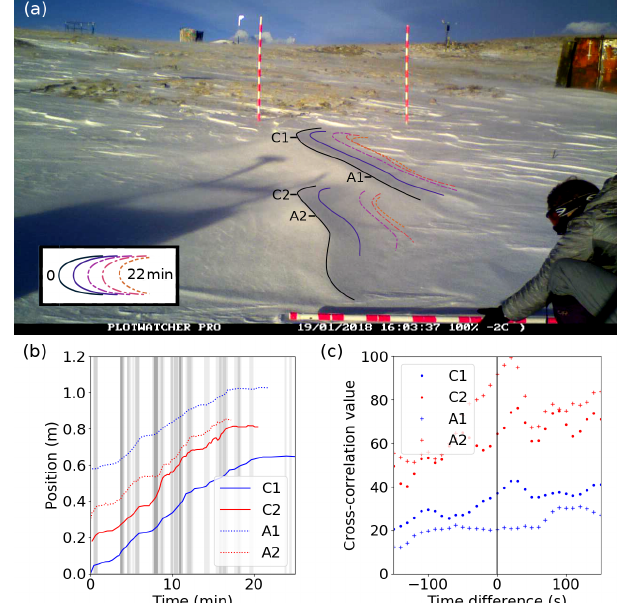
Figure 4. Movement of two barchan dunes on Niwot Ridge, Col- orado, from 16:03 to 16:28 on 19 January 2018, and analysis of the effect of pulses of blowing snow on dune movement. See video S1 at 1:07. (a) Dunes at 16:03. Colored lines show the crest posi- tion through time, taken from time-lapse imagery. Poles have 10cm stripes. Horizontal pole is held 2m in front of vertical poles, which are 2m apart. (b) Horizontal (left to right) positions of the dune crests at points C1, A1, C2, and A2 at 10s intervals. The back- ground is shaded when blowing snow is visible in the footage. (c) Cross-correlation of the presence of blowing snow with the in- stantaneous velocities of the